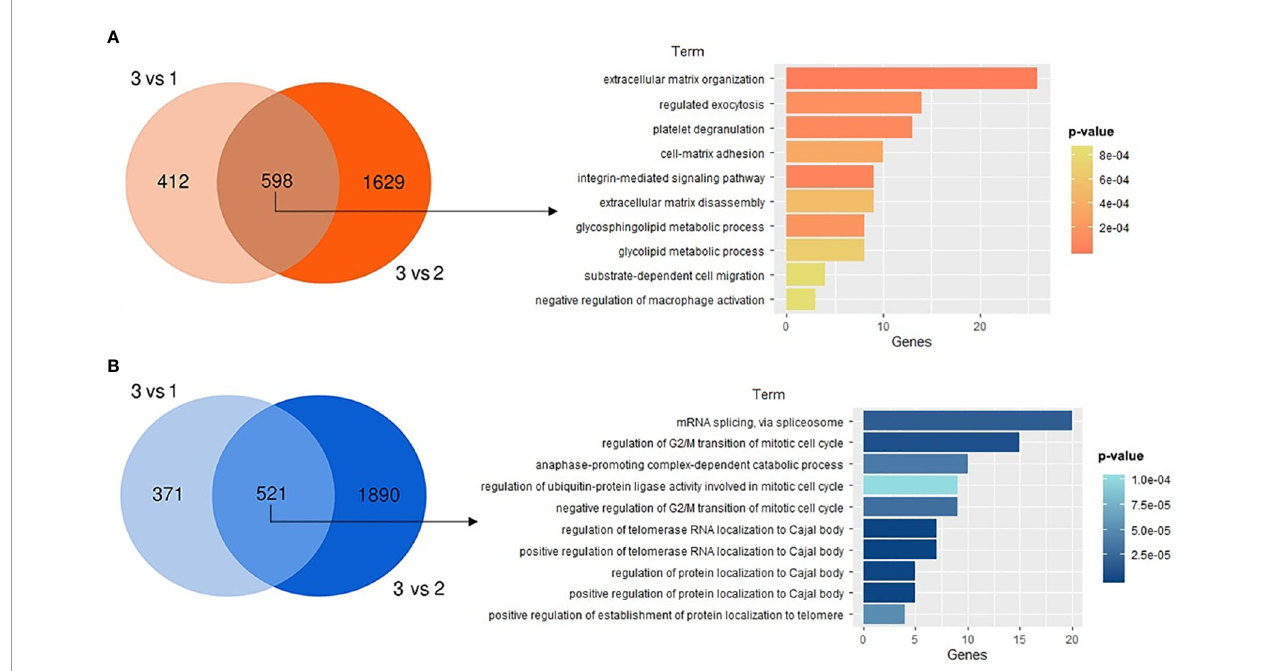
FIGURE 6 | Gene ontology (GO) analysis for GBM group 3 regarding the other two GBM groups. Venn diagrams presenting the numerous differentially expressed genes and their corresponding top 10 enriched GO terms are shown for (A) upregulated or (B) downregulated regulated genes in cluster 3 vs clusters 1 and 2. In plots, for signi fi cant pathways listed, p-values are shown in